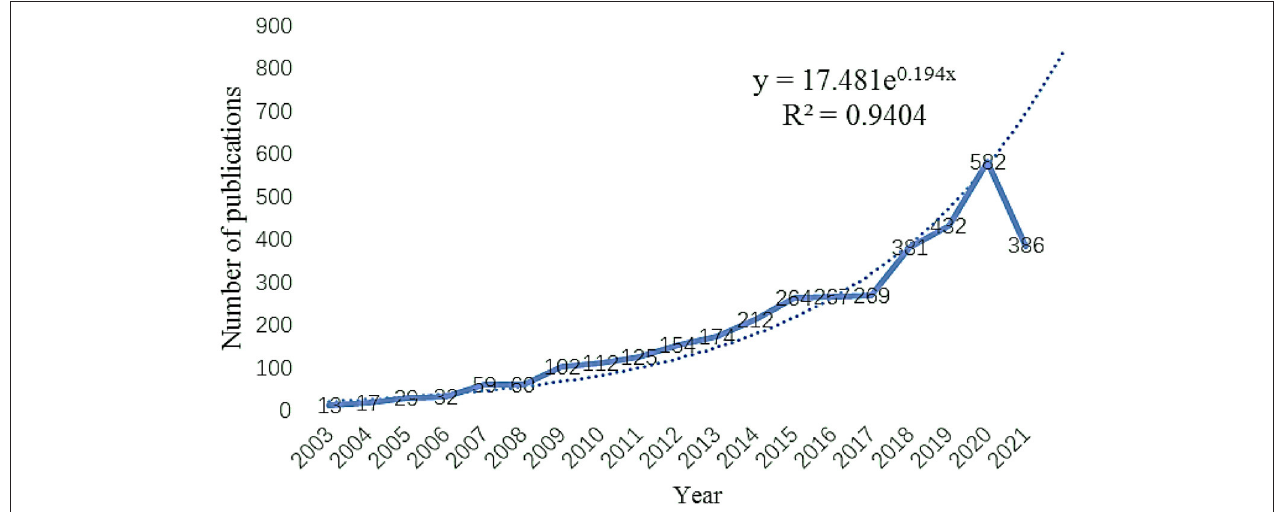
FIGURE 1 | Studies selection flow diagram.